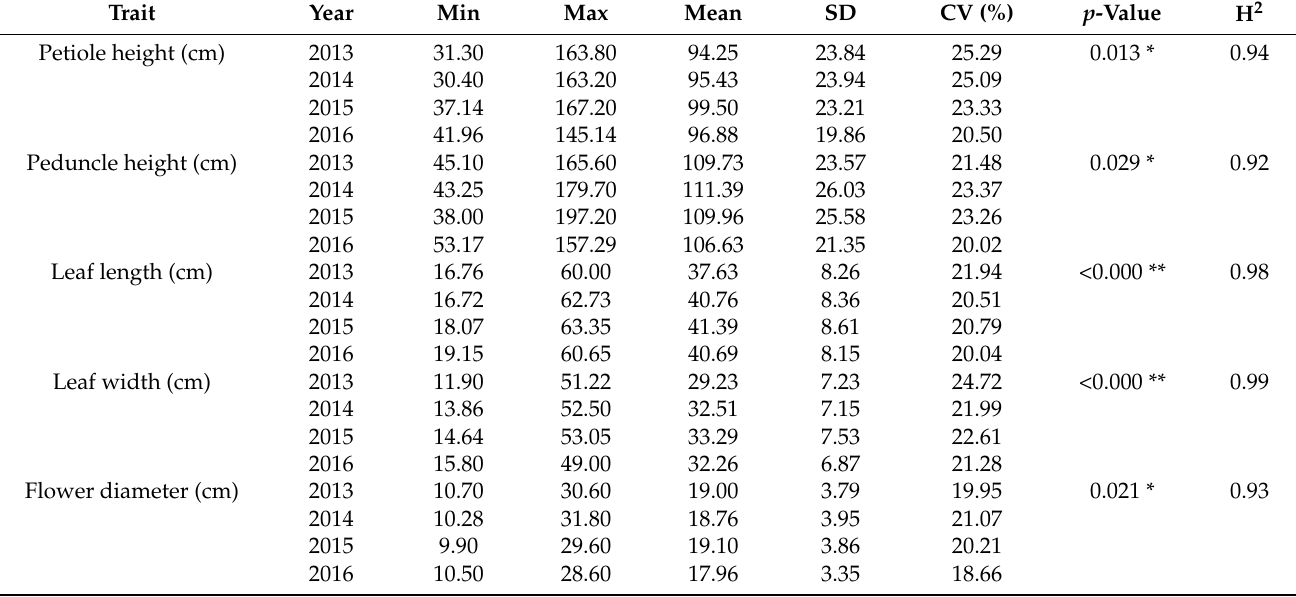
Table 1. Phenotypic measurement of the PA-related traits of the 293 lotus